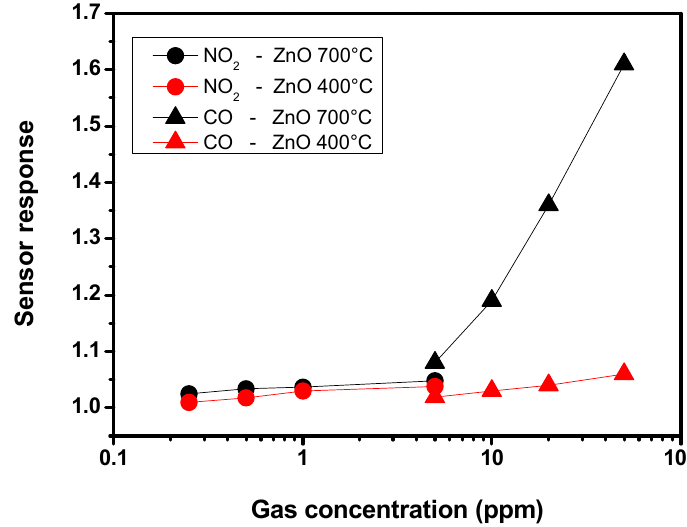
Figure 6. Response of ZnO nanoparticles annealed at 400 °C (red) and 700 °C (black) as a concentrations at 350 function of CO and NO 2